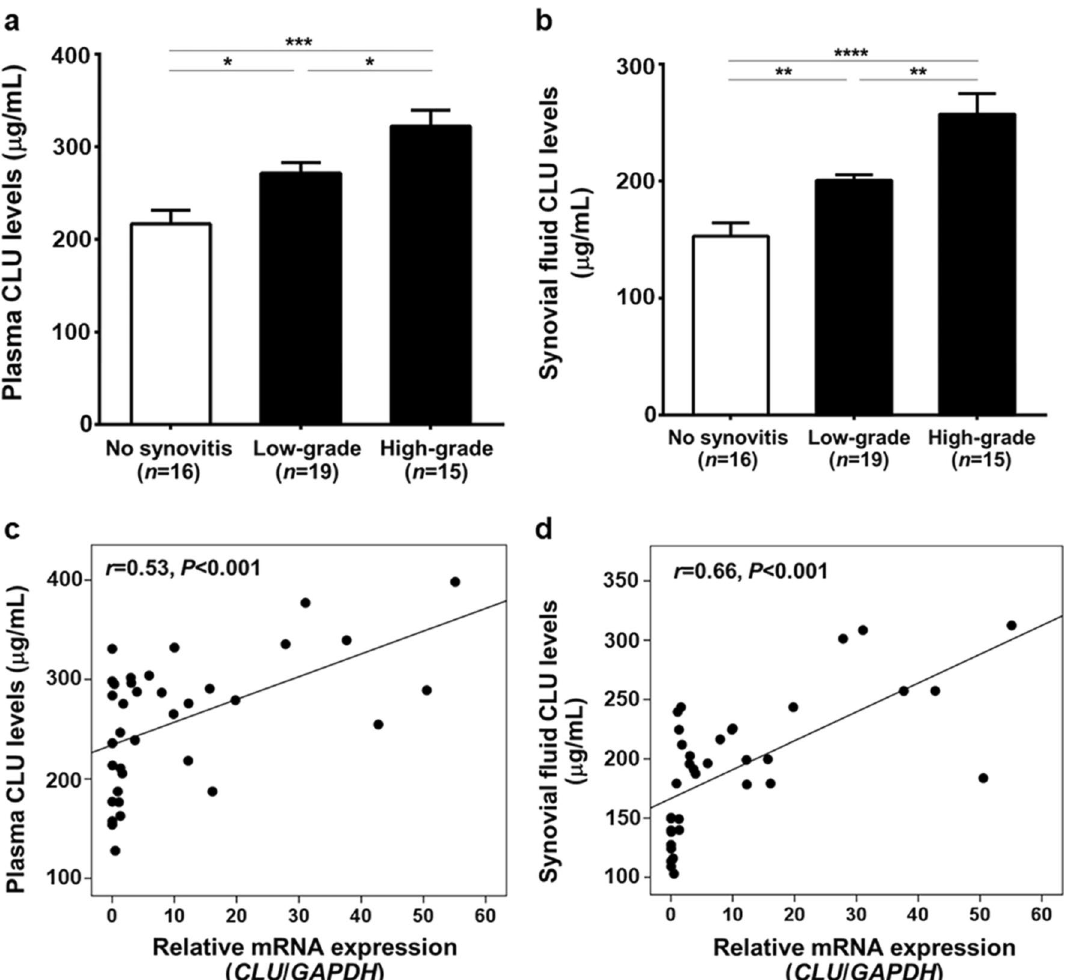
Figure 2. CLU protein levels in the circulation and synovial fluid of knee OA patients with different groups based on degree of synovitis. ( a ) Plasma CLU levels. ( b ) Synovial fluid of CLU levels. ( c ) Direct link between plasma CLU and its mRNA expression. ( d ) Positive association between synovial fluid CLU and its mRNA expression. * P < 0.05, ** P < 0.01, ** *P < 0.001, **** P < 0.0001 for comparisons among knee OA with different groups with regard to synovitis severity.